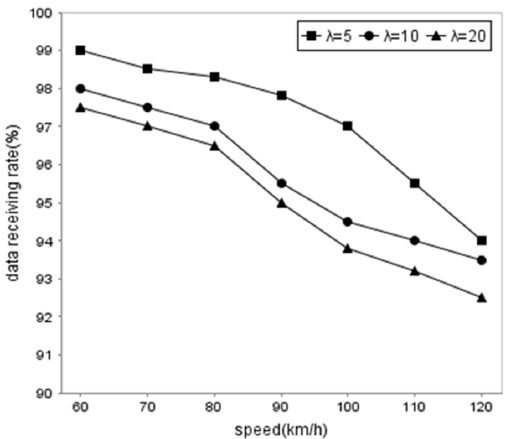
Figure 7. Comparison of data receiving rate generate in different traffic flow, average speed.